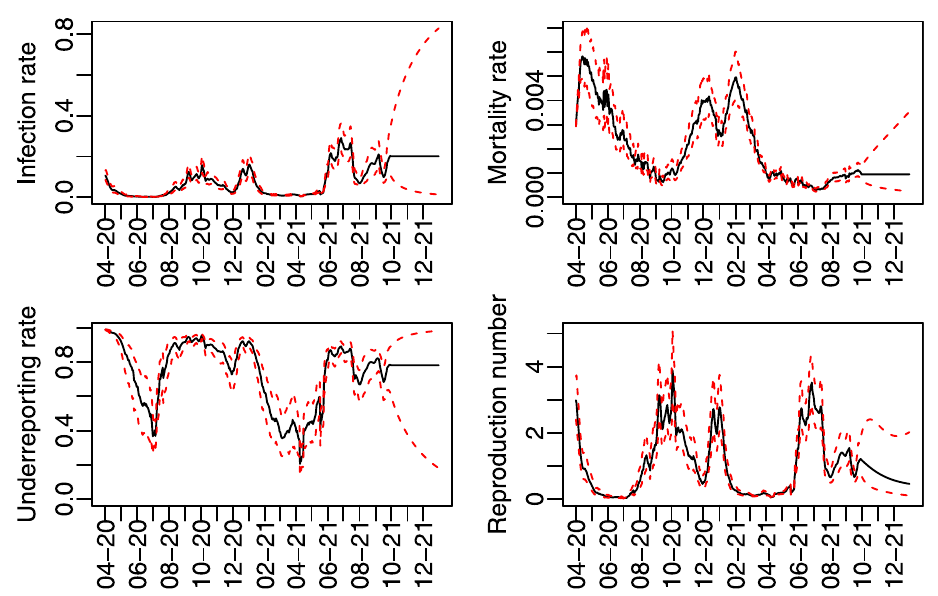
Fig 2. Time varying predicted infection, mortality, subnotification rates and effective reproduction